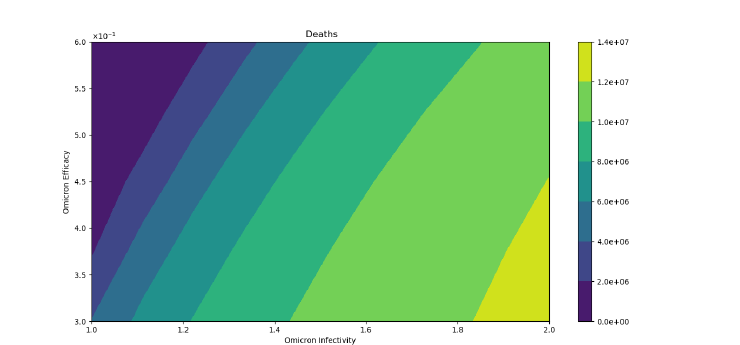
Figure 8. In silico simulation of the Omicron wave model (2). The outcomes regarding total deaths. As the Omicron infectivity rate increases, the final total number of deaths increases. As can be observed, the number of deaths increases despite assuming the same case fatality rate for the two